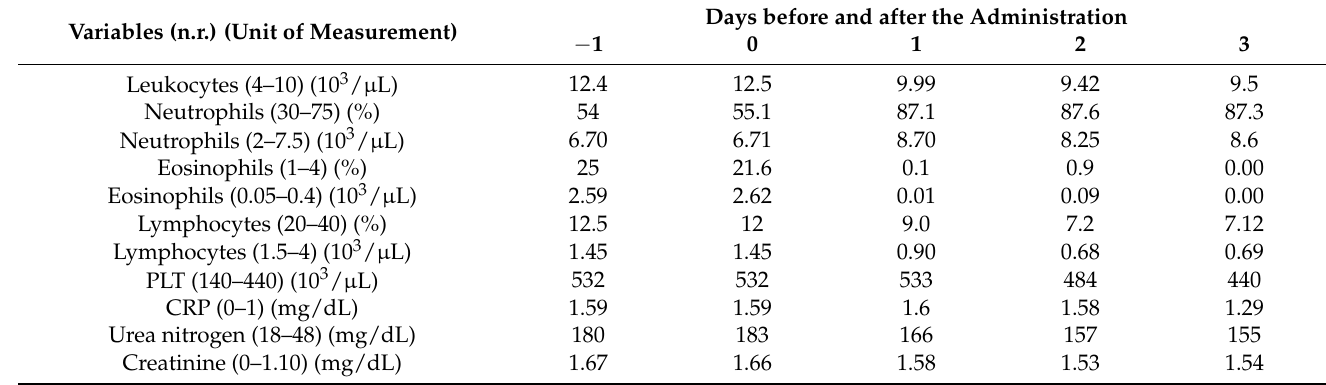
Table 3. Laboratory parameters before and after the administration of